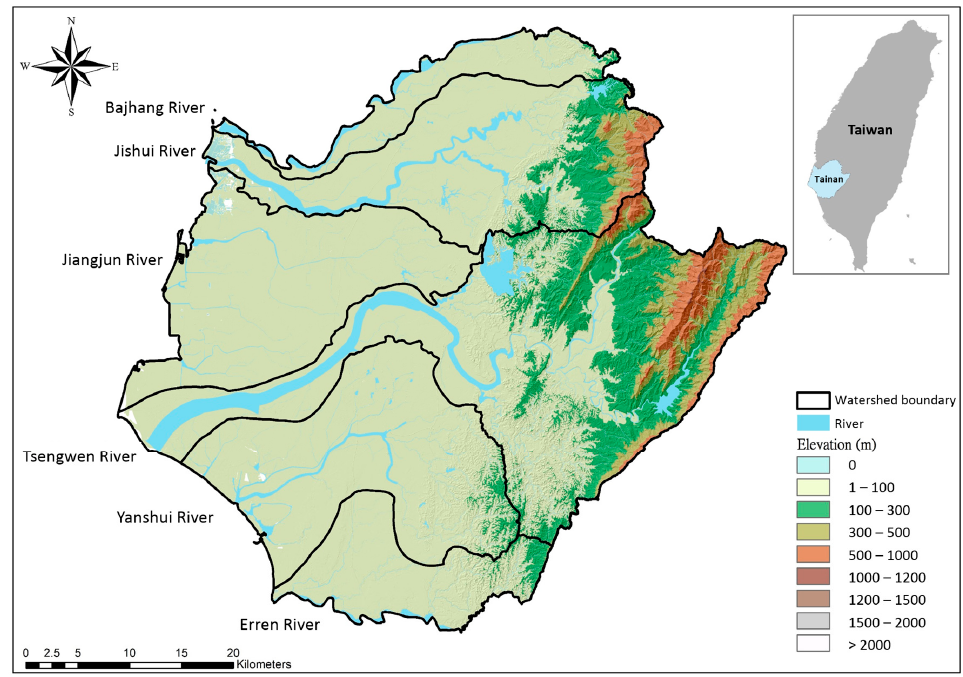
Figure 1. Location, river distribution and topography of Tainan City.